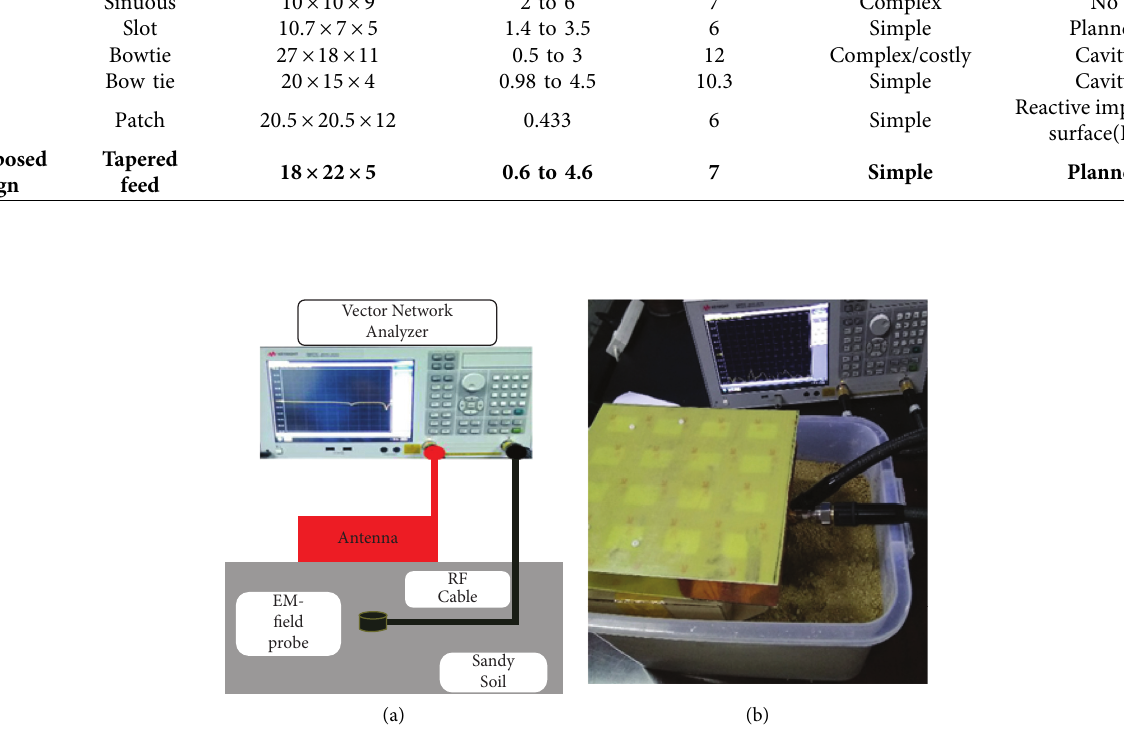
Figure 12: Sandbox experiment: (a) diagram of the experiment; (b) picture of the